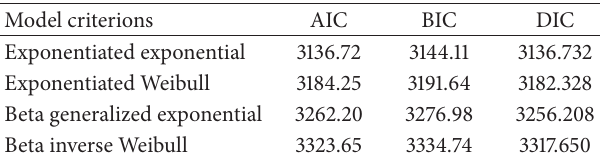
Table 3: Selection of the best model for Black Hispanic females on the basis of AIC, BIC, and DIC